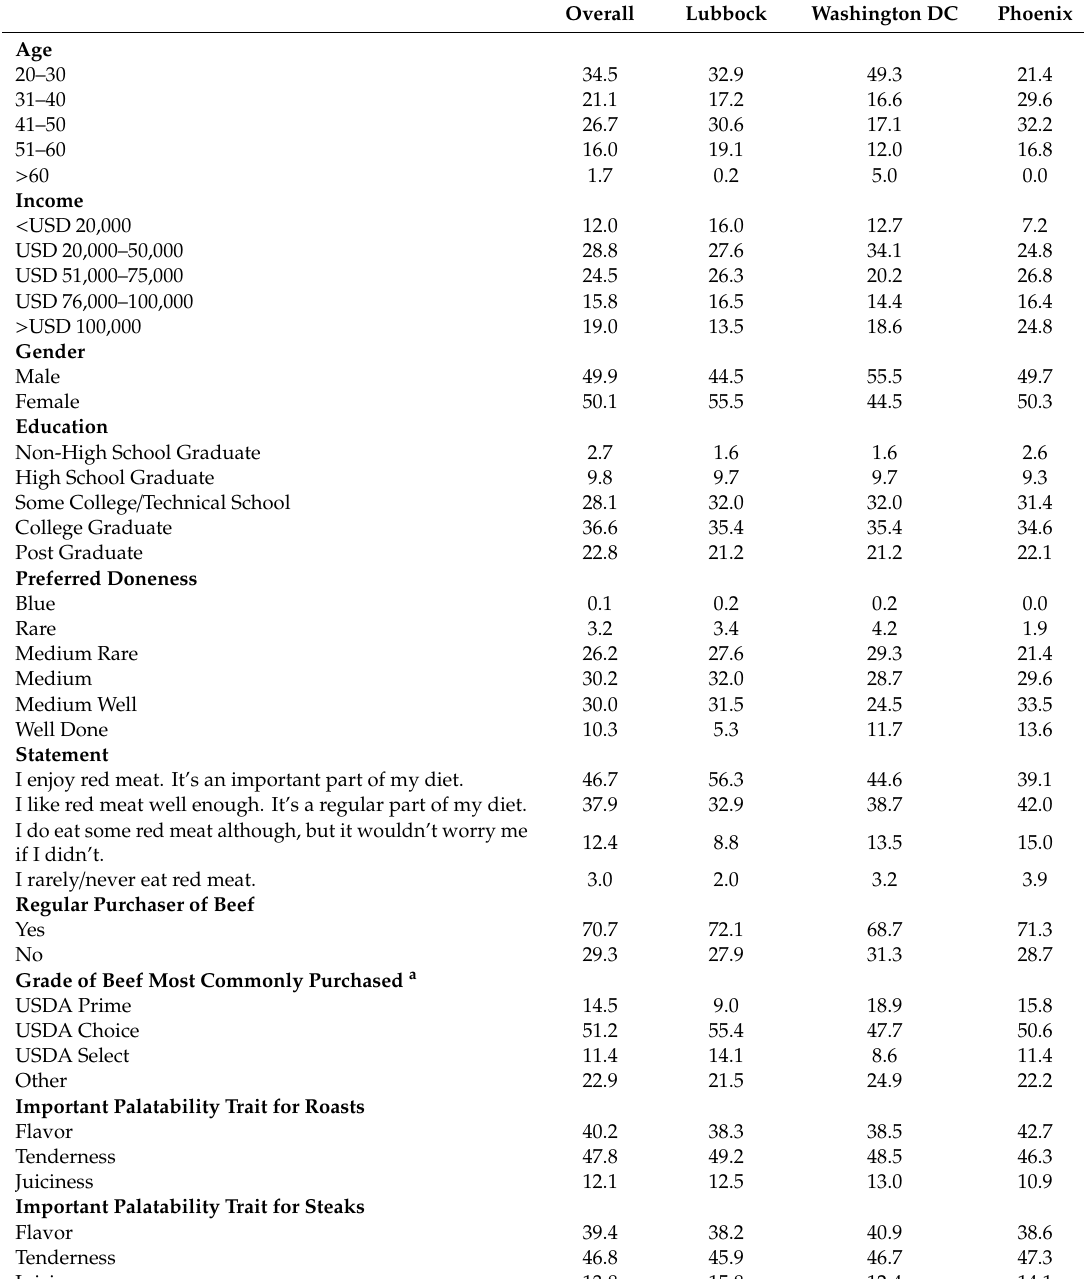
Table 1. Consumer demographics and responses to beef preference statements. Reported as percentages of consumers ( n = 1440; 480 /